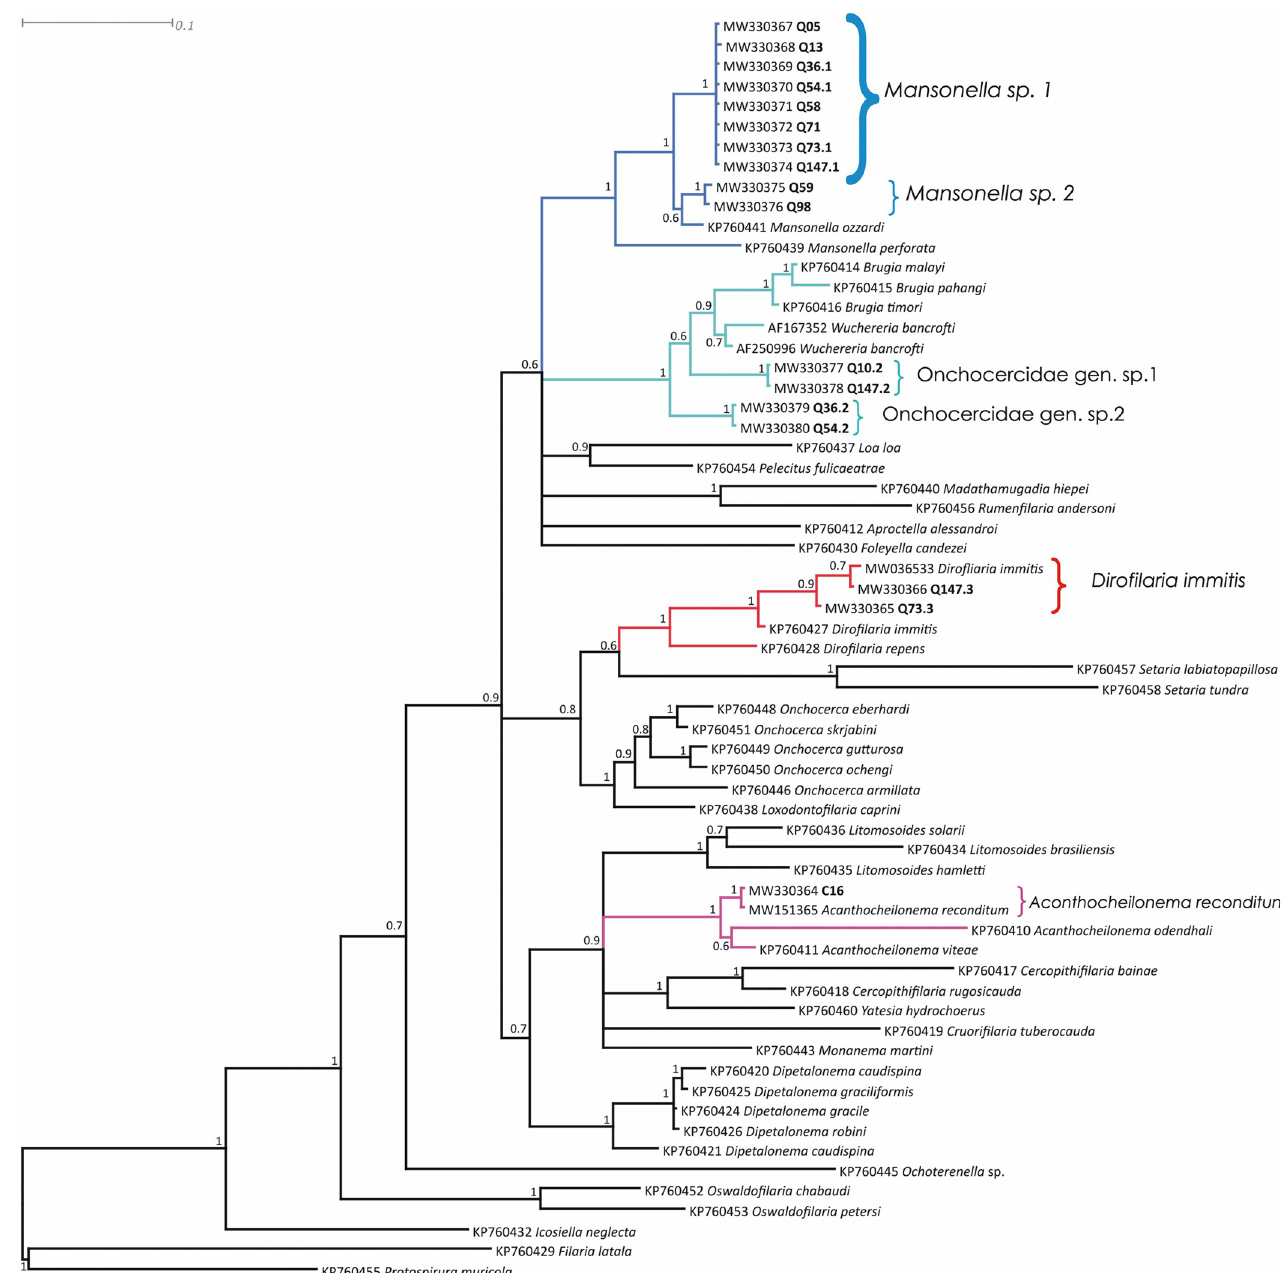
Fig 3. Bayesian phylogenetic tree of myoHC gene sequences of Onchocercidae microfilariae haplotypes present in blood samples of ring-tailed coatis ( Nasua nasua ) and domestic dog from the Iguac¸u National Park. Isolates from this study are highlighted. The blue branches are related to Mansonella spp clade, the cyan branches are related to the sheated species clade, the red branches represent Dirofilaria immitis clade, and the magenta branches represent Acanthocheilonema reconditum